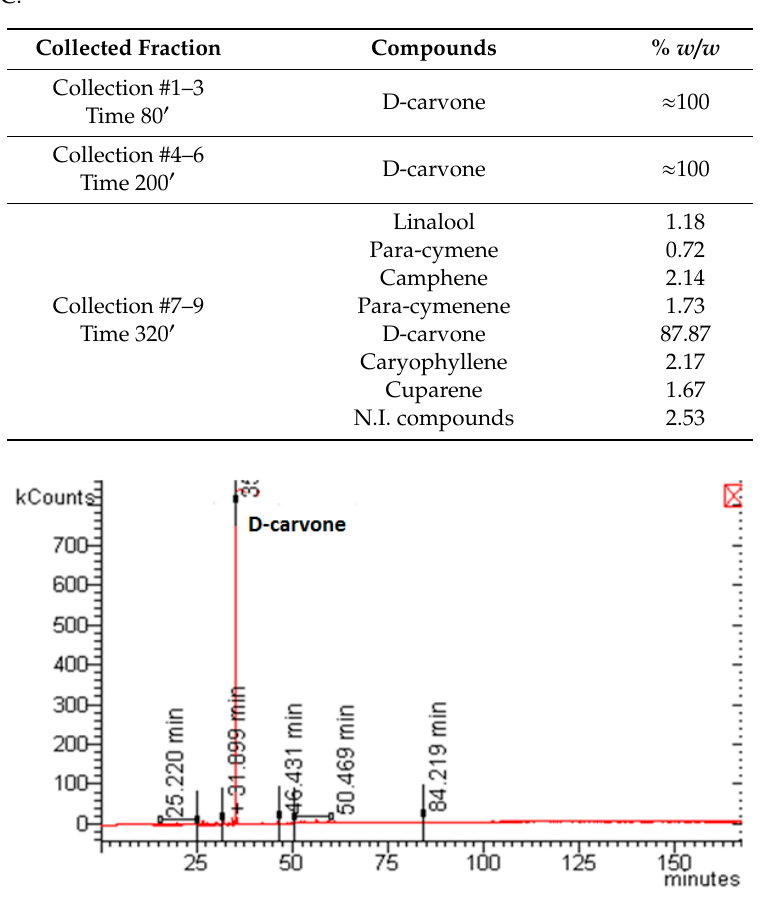
Figure 3. Example of a GC-MS trace related to the extract collected in the II separator.